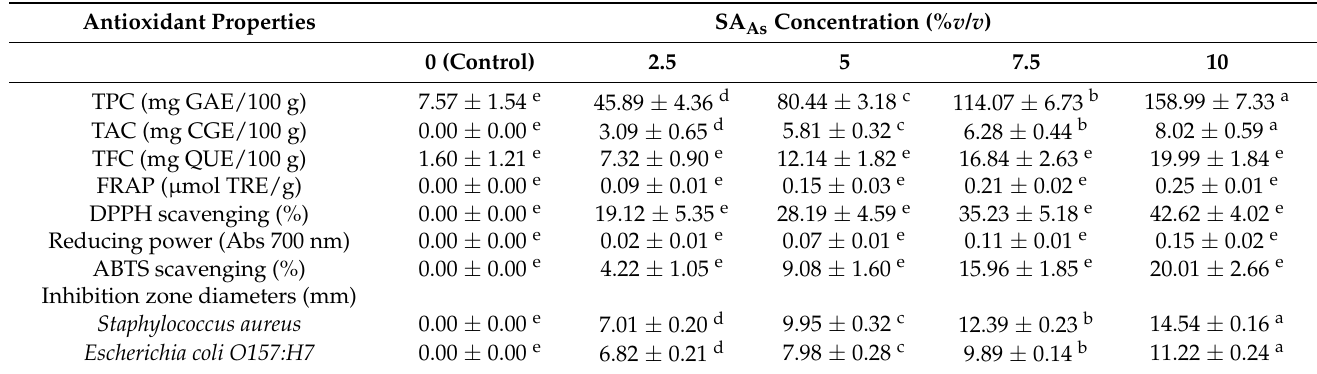
Table 2. Effect of SA As concentrations on antioxidant and antibacterial properties of salep mucilage edible indicator